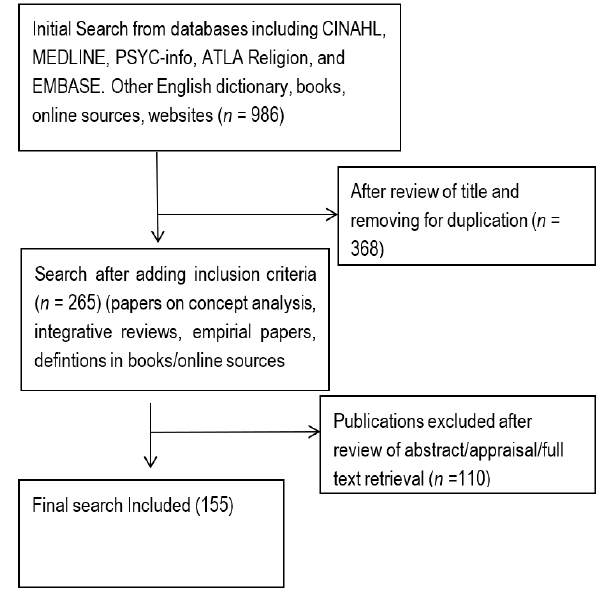
Figure 1. Search Figure 1. Search process.